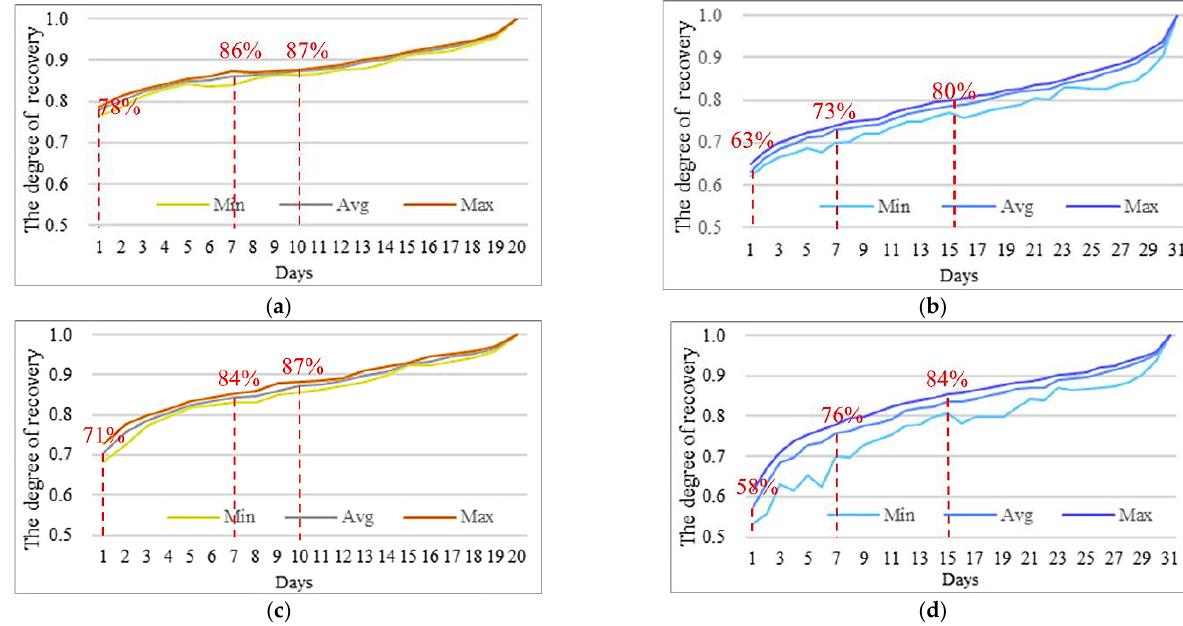
Figure 14. The degree of travel spatial structure and flow recovery. ( a ) Travel spatial structure in Shenzhen. ( b ) Travel spatial structure in NYC. ( c ) Travel spatial flow in Shenzhen. ( d ) Travel spatial flow in NYC.